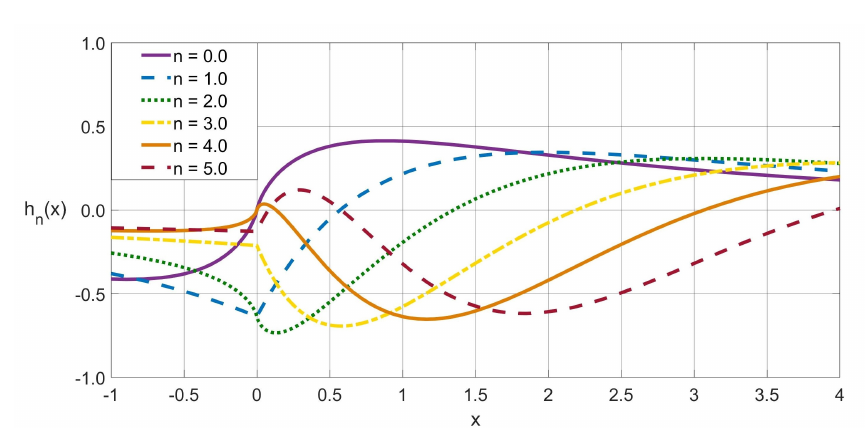
Figure 3. Havelock functions with positive integer orders as a function of argument x